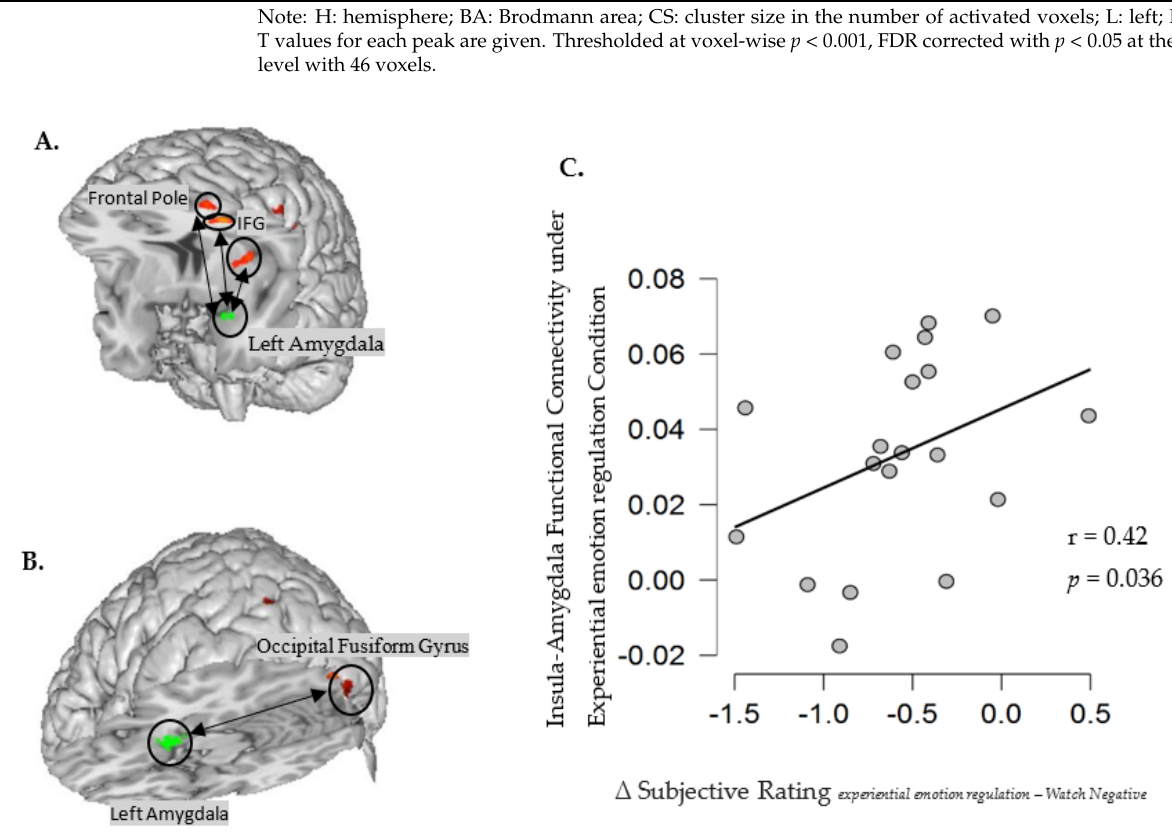
Figure 4. ( A ) gPPI results for experiential emotion regulation. During experiential emotion regulation, activation increases in the insular cortex and several prefrontal areas (including the prefrontal pole and inferior frontal gyrus), were related to a decrease in the left amygdala activity. ( B ) gPPI results in cognitive defusion. An activation increase in the occipital fusiform gyrus was associated with a decrease in the left amygdala activation in the cognitive defusion condition. ( C ) The extracted beta values (i.e., the average Fisher-transformed correlations with the left amygdala within the insular cortex, indicated as Y -axis) were found to be positively correlated with the relatively more positive subjective ratings after experiential emotion regulation relative to the watch negative condition ( ∆ Subjective Rating experiential emotion regulation—Watch Negative